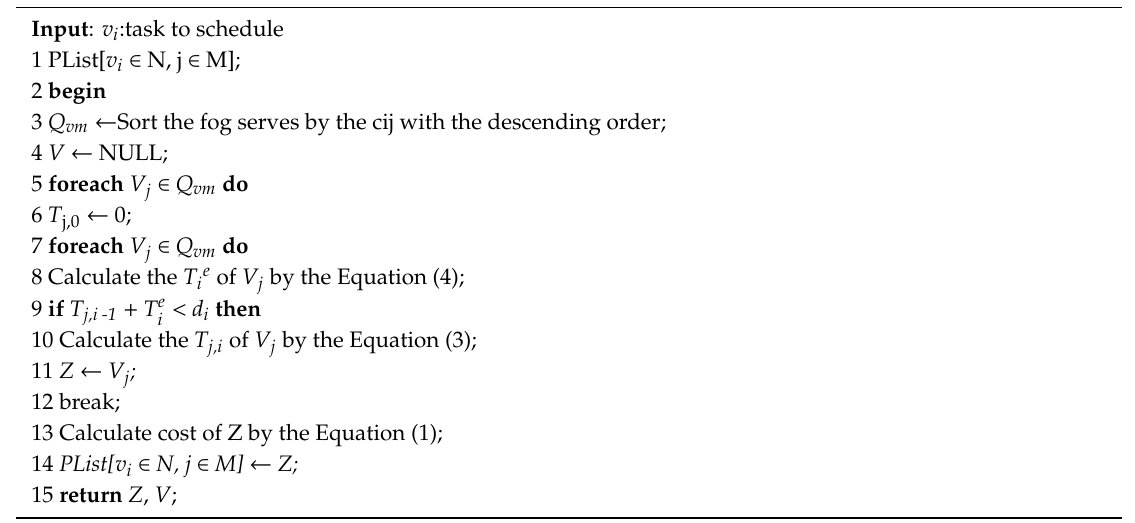
Algorithm 2: Initial Task